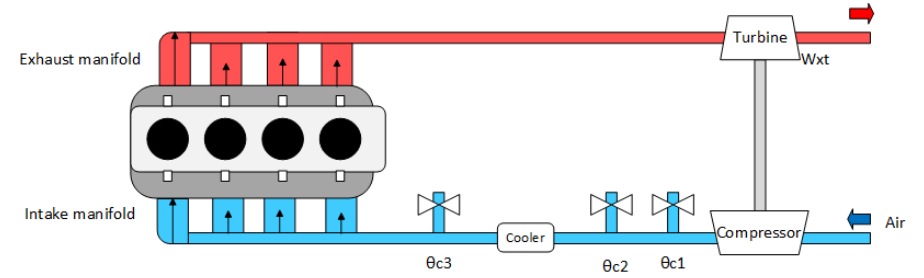
Figure 7. Manual valves to control the charged air pressure.